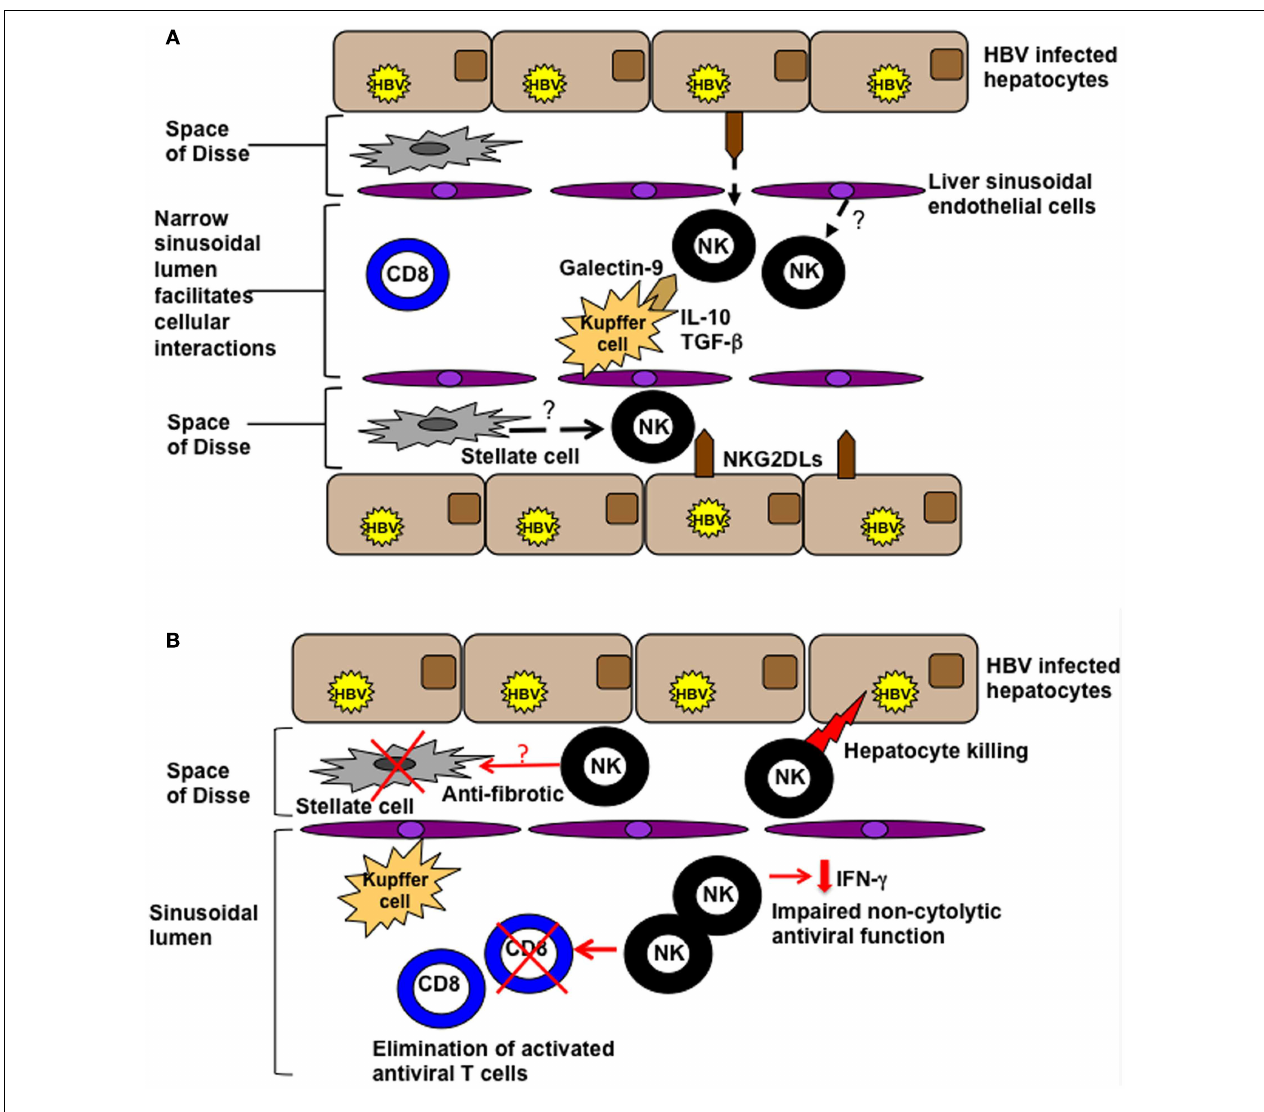
ligands expressed by liver sinusoidal endothelial cells or stellate cells. (B) Functions of NK cells in the HBV-infected liver. NK cells can utilize death ligands to kill hepatocytes (contributing to liver damage) and HBV-specificT cells (curtailing antiviral immunity).They exhibit impaired non-cytolytic antiviral function (reduced IFN- γ production), but may serve a protective function to limit liver fibrosis by killing activated stellate (pro-fibrotic)